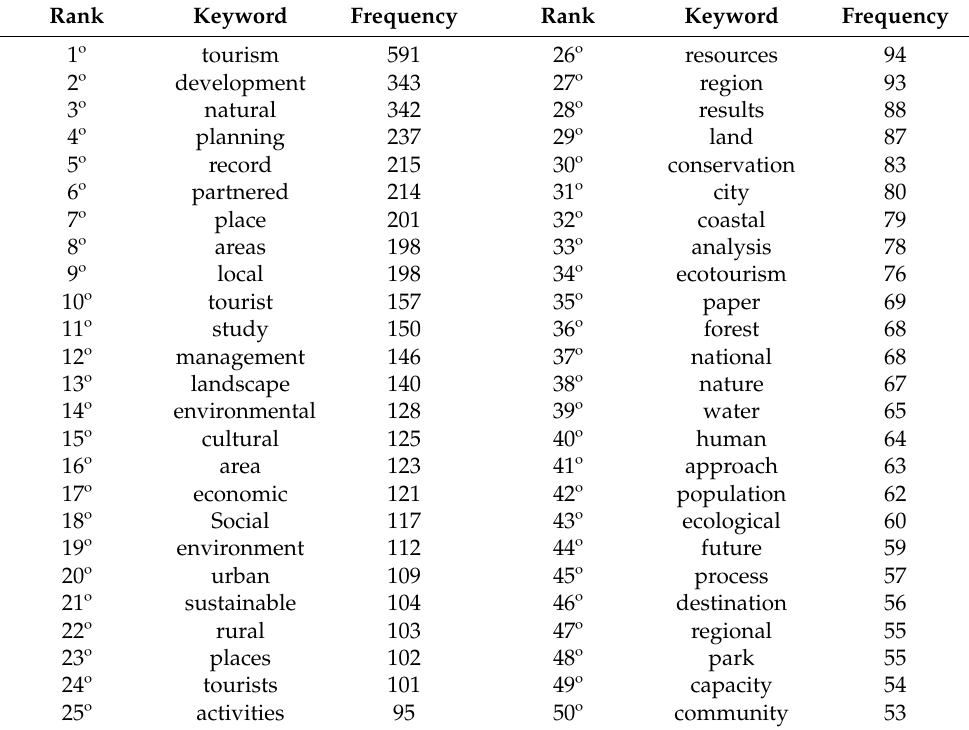
Table 3. Abstracts frequency analysis ( n = 63,596). Ranking of words with greater